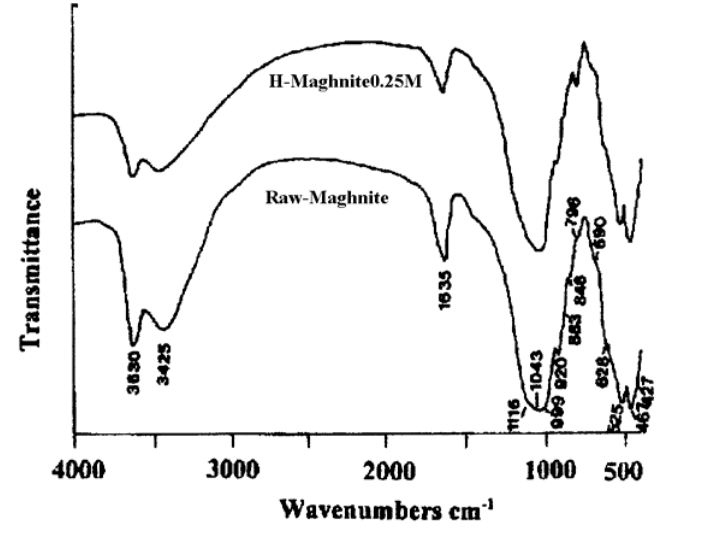
Figure 2. IR Spectra of (a) untreated Clay “Raw-Maghnite” and (b) Acid treated Clay “H-